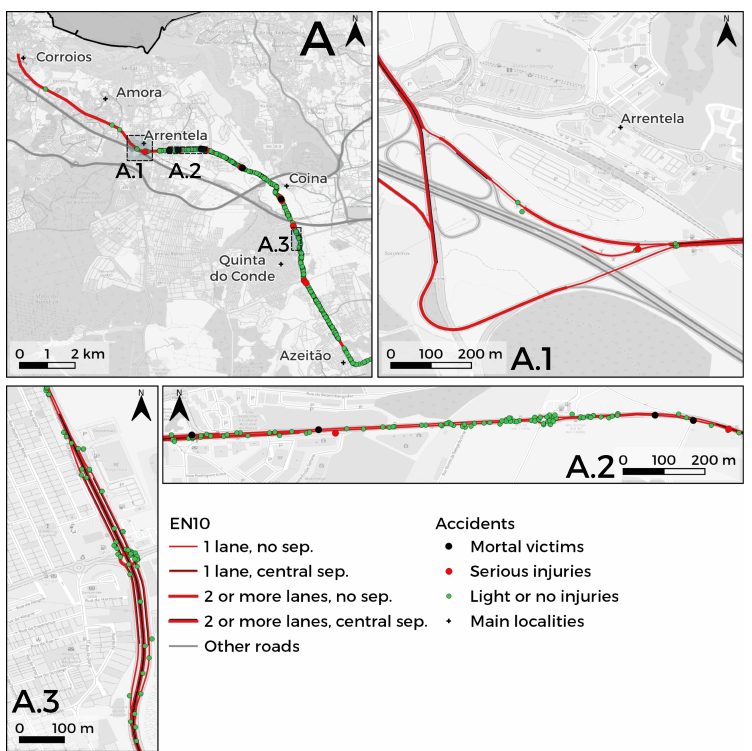
Figure 2. Section A and its main areas ( A.1 – A.3 ); RTA between 2016 and 2019 according to their severity. Note: sep = separator, i.e., protective